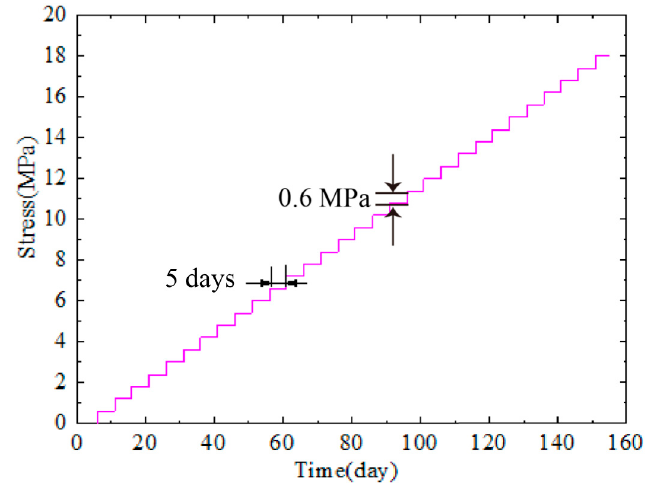
Figure 4. Loading history.